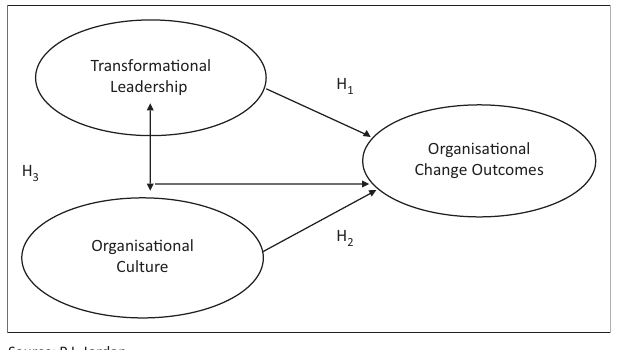
FIGURE 1: Theoretical